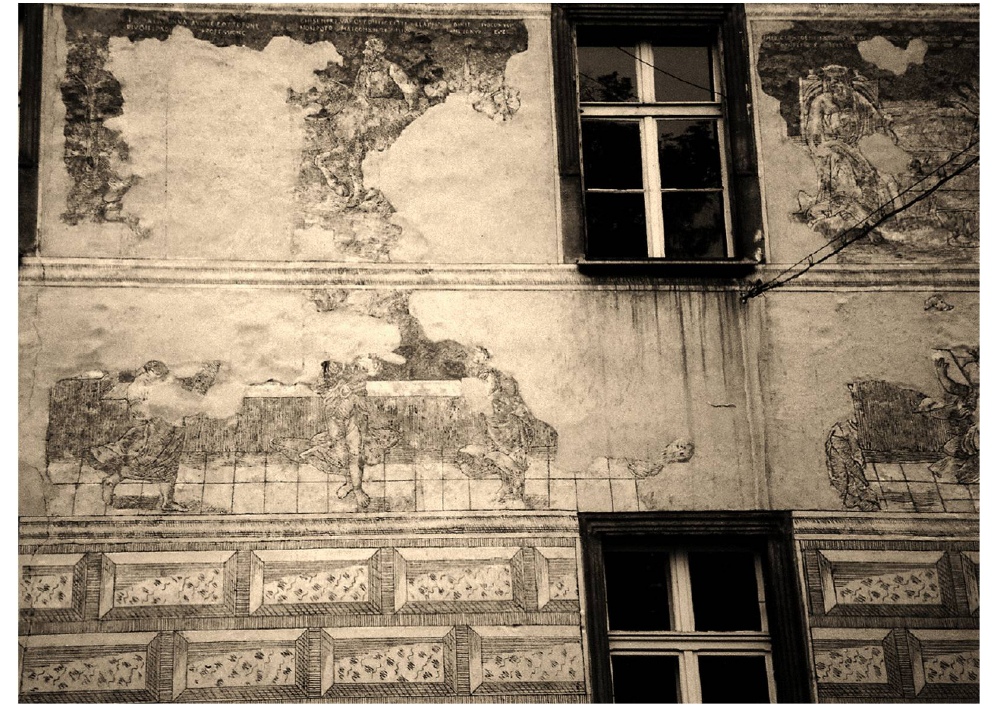
Figure 8. Remains of sgraffito decorations on the elevations of the castle in Prószków are united with a uniform background. Condition before renovation in 2011. Author’s photo.